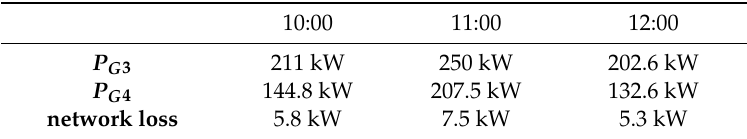
Table 5. Virtual power active output and network loss for 10:00–12:00.